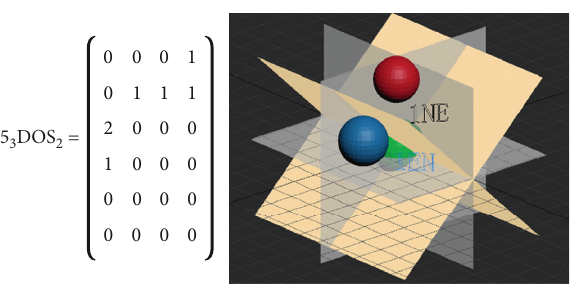
Figure 14: R5 3 DOS-intersection model in Example